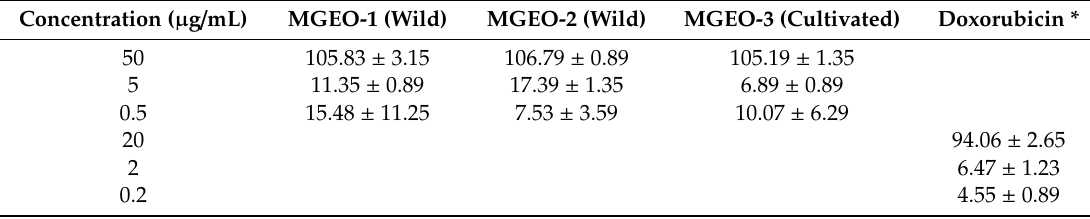
Table 5. Percentage of nitric oxide (NO) inhibition (mean ± SD) observed with MGEOs 1–3 in lipopolysaccharide (LPS)-activated RAW264.7 cells incubated for 24 h with di ff erent MGEO concentrations.